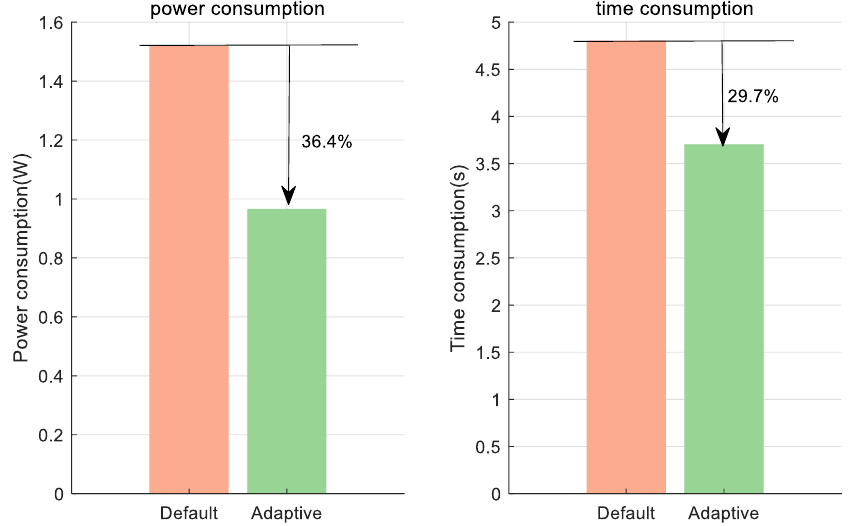
Figure 16. power consumption and time